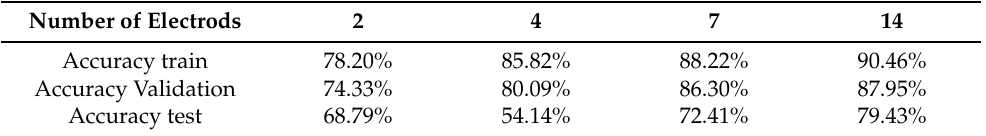
Table 7. Training, validation and testing accuracy of the various numbers of electrodes without data augmentation (DA).